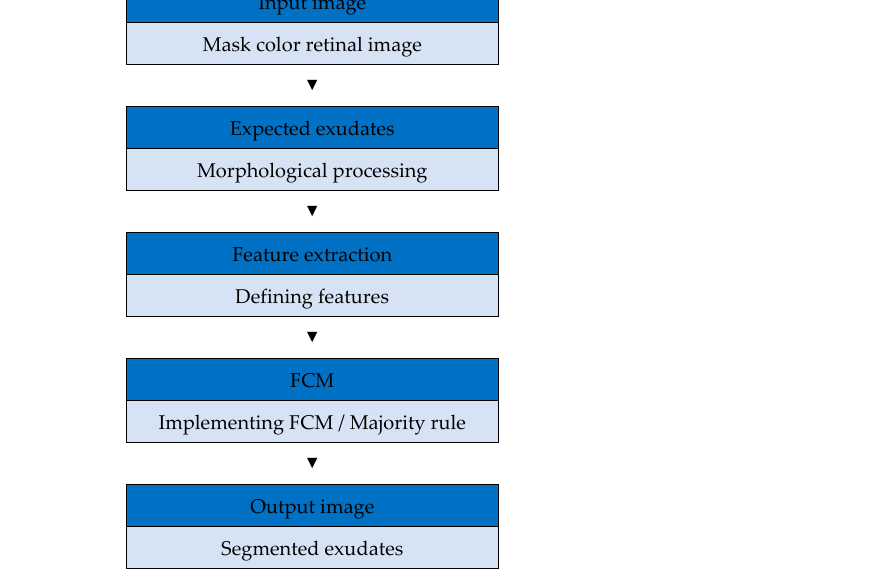
Figure 4. Flowchart of the proposed algorithm. FCM, fuzzy C-means clustering.